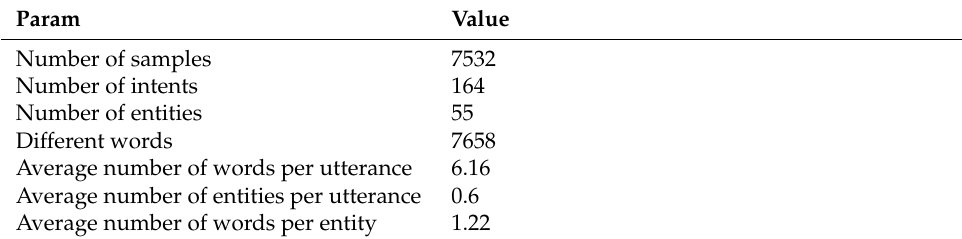
Table 1. Main features of selection of Hispabot-Covid19 corpus used in paper. Param Value Number of